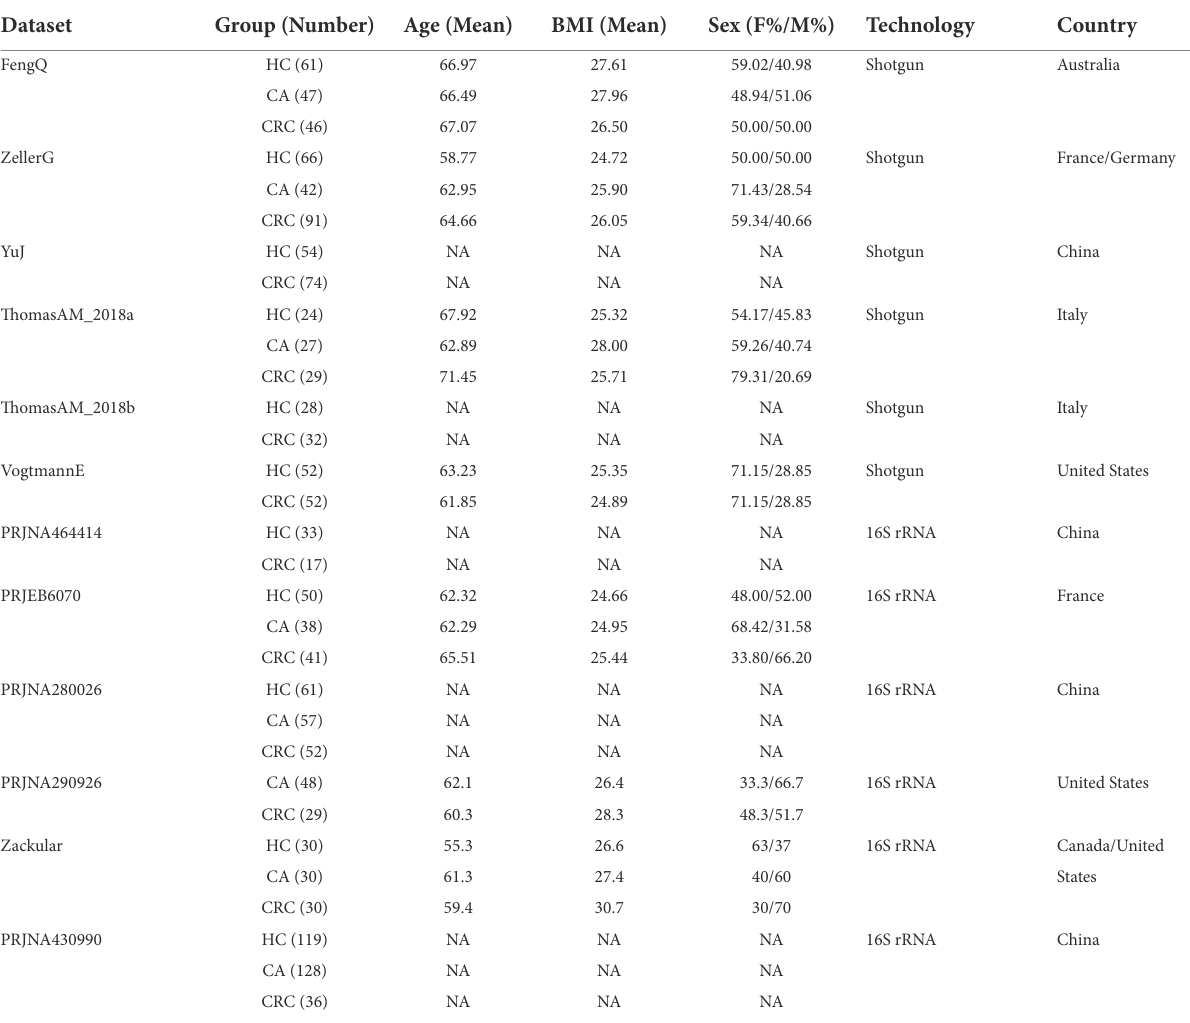
TABLE 1 The demographic information of CRC datasets.